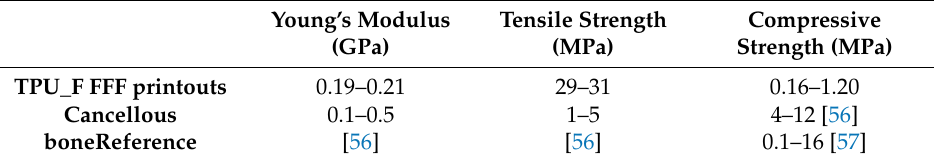
Table 7. Summary of the properties of TPU_F printed structures vs cancellous human bone.